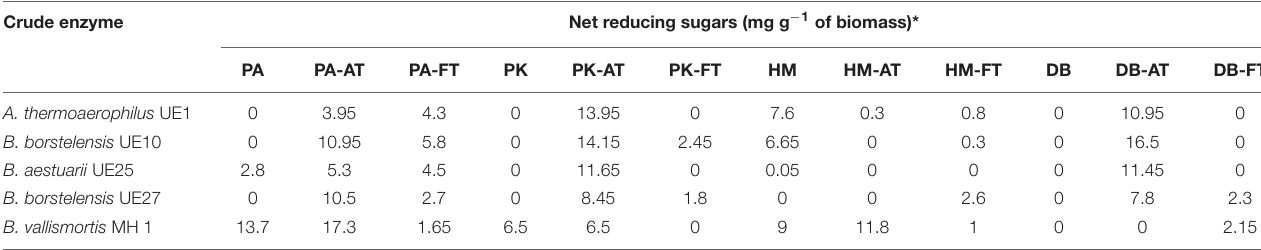
TABLE 2 | Saccharification of untreated, acid-treated (-AT), and freeze-thawed (-FT) stem and leaves of Desmostachya bipinnata (DB), Halopyrum mucronatum (HM), Phragmites karka (PK), and Panicum antidotale (PA). Crude enzyme Net reducing sugars (mg g − 1 of biomass)*